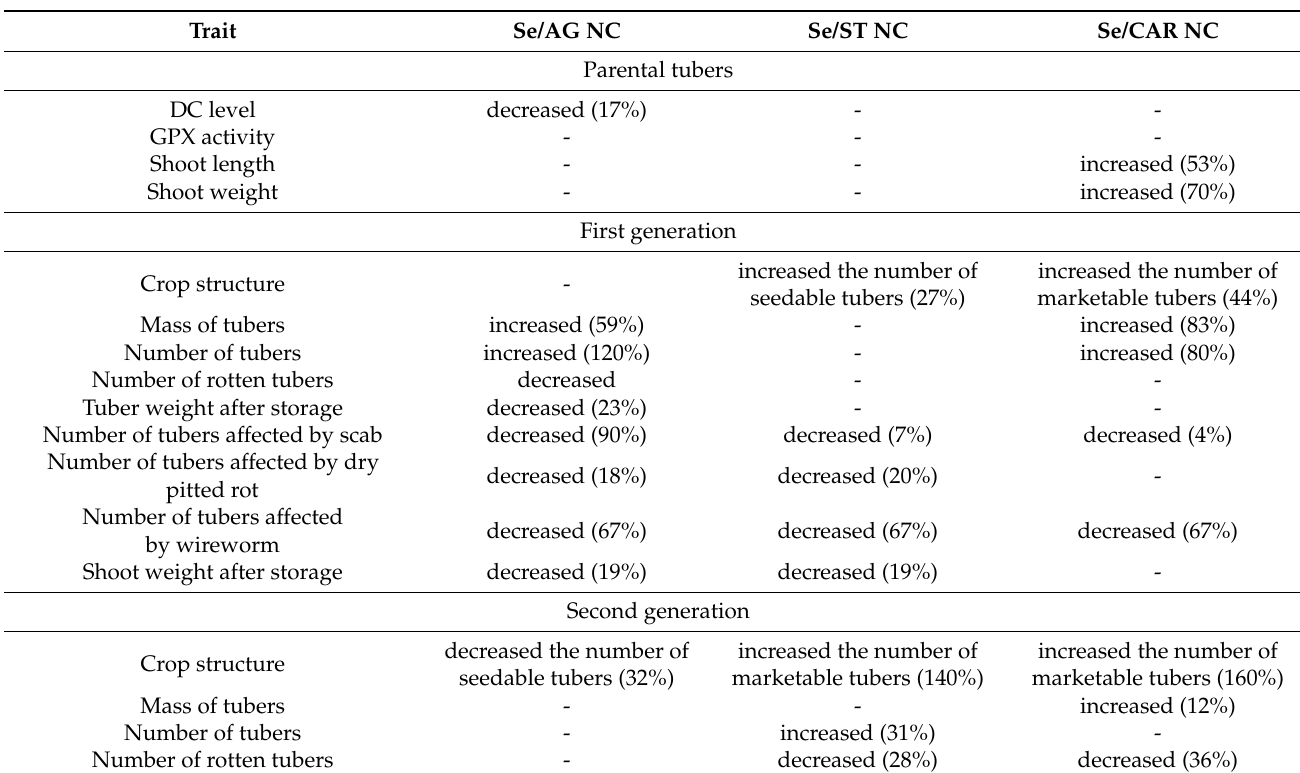
Table 6. Summary data on the effect of selenium (Se) nanocomposites (NCs) on parental potato tuber traits and in the first and second generations in the field